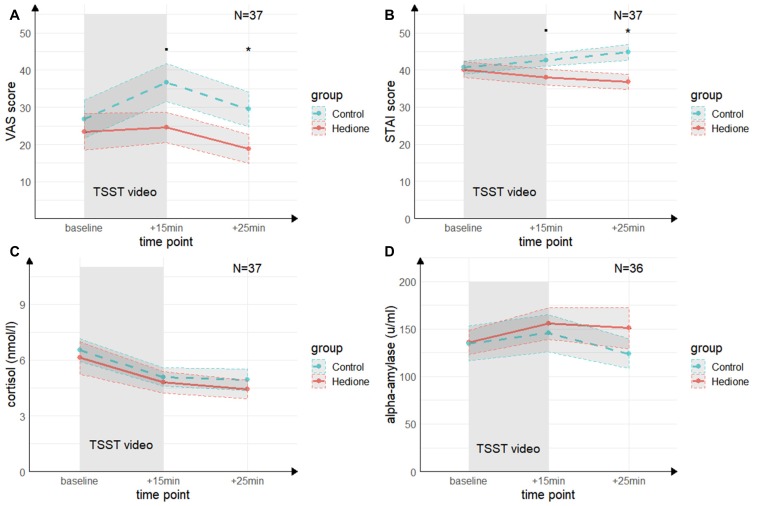
Group differences in empathic stress in Experiment 2. (A) Ratings of the visual analog scale (VAS) tend to be higher in the control group directly after the TSST (+15 min) and are significantly higher in the control group 25 min after (+25 min) the beginning of TSST. (B) Ratings of the state scale of the State Trait Anxiety Inventory (STAI) tend to be higher in the control group directly after the TSST (+15 min) and are significantly higher in the control group 25 min after (+25 min) the beginning of TSST. (C) There were no group differences in salivary cortisol levels and (D) in salivary alpha-amylase levels at neither time point. Note: •p = 0.06, *p < 0.05. Shaded errors denote SEM.